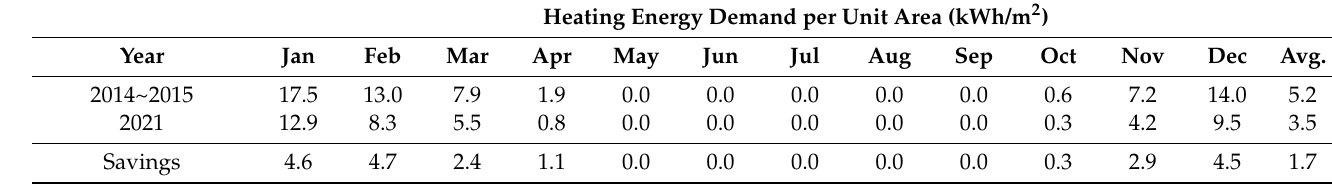
Table 3. Comparison of monthly heating energy demand per unit